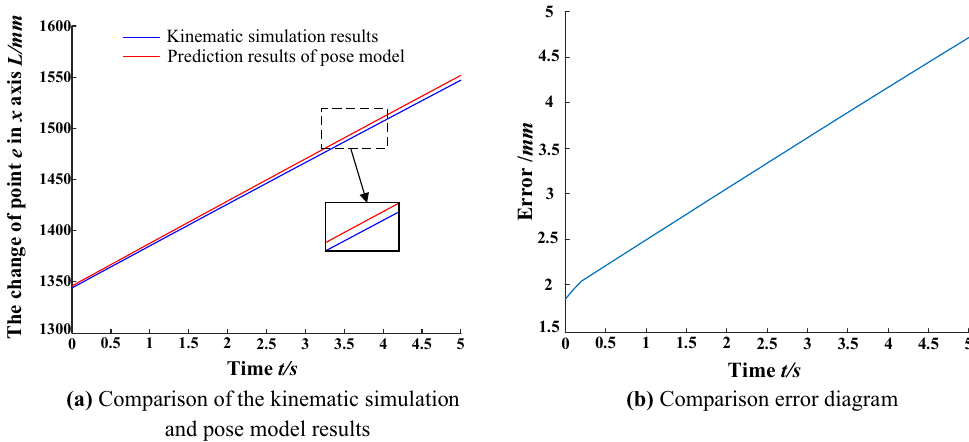
Figure 13. Comparison of the kinematic simulation results of the x-axis position change of the monitoring points.